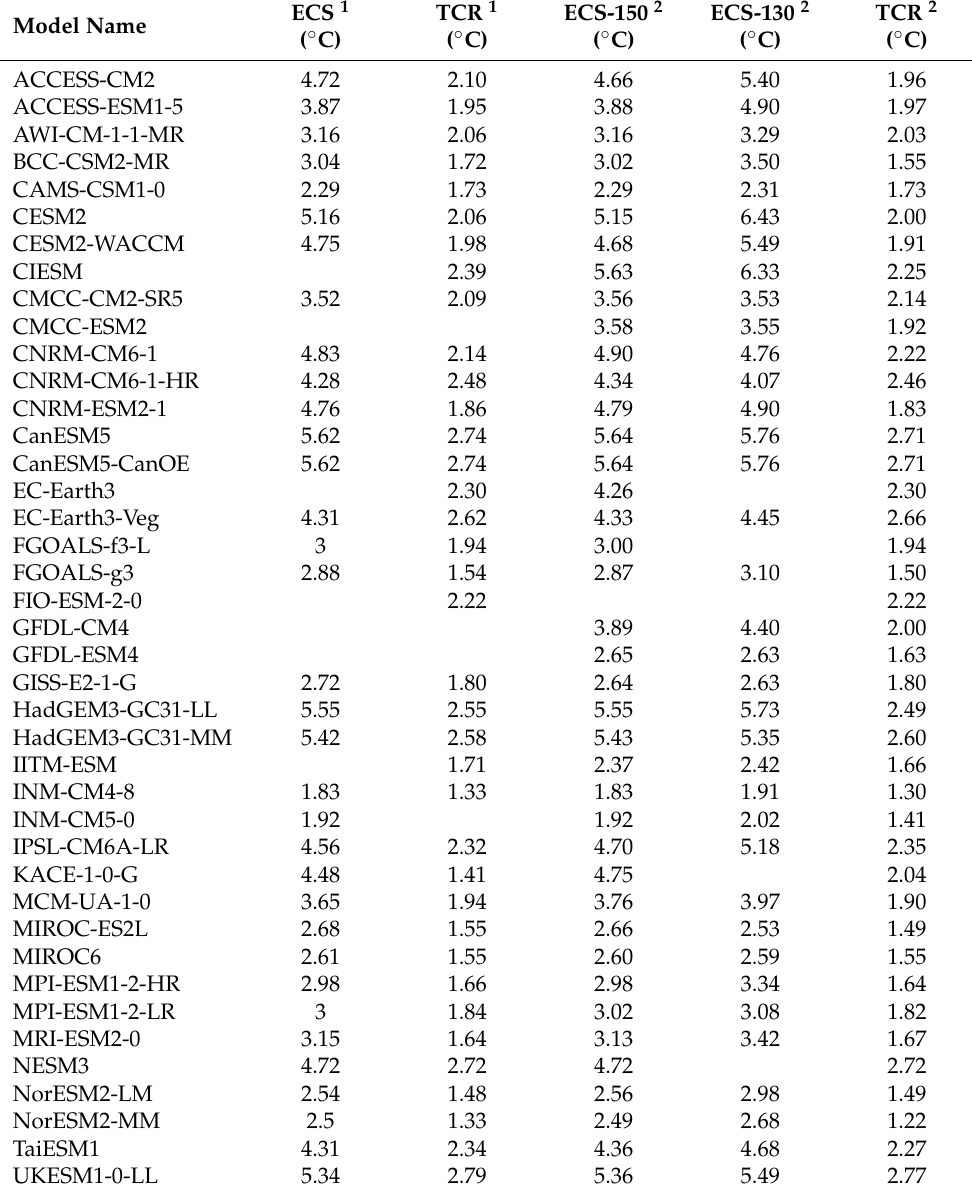
Table A1. Equilibrium Climate Sensitivity (ECS) and Transient Climate Response (TCR) of the CMIP6 Global Circulation Models